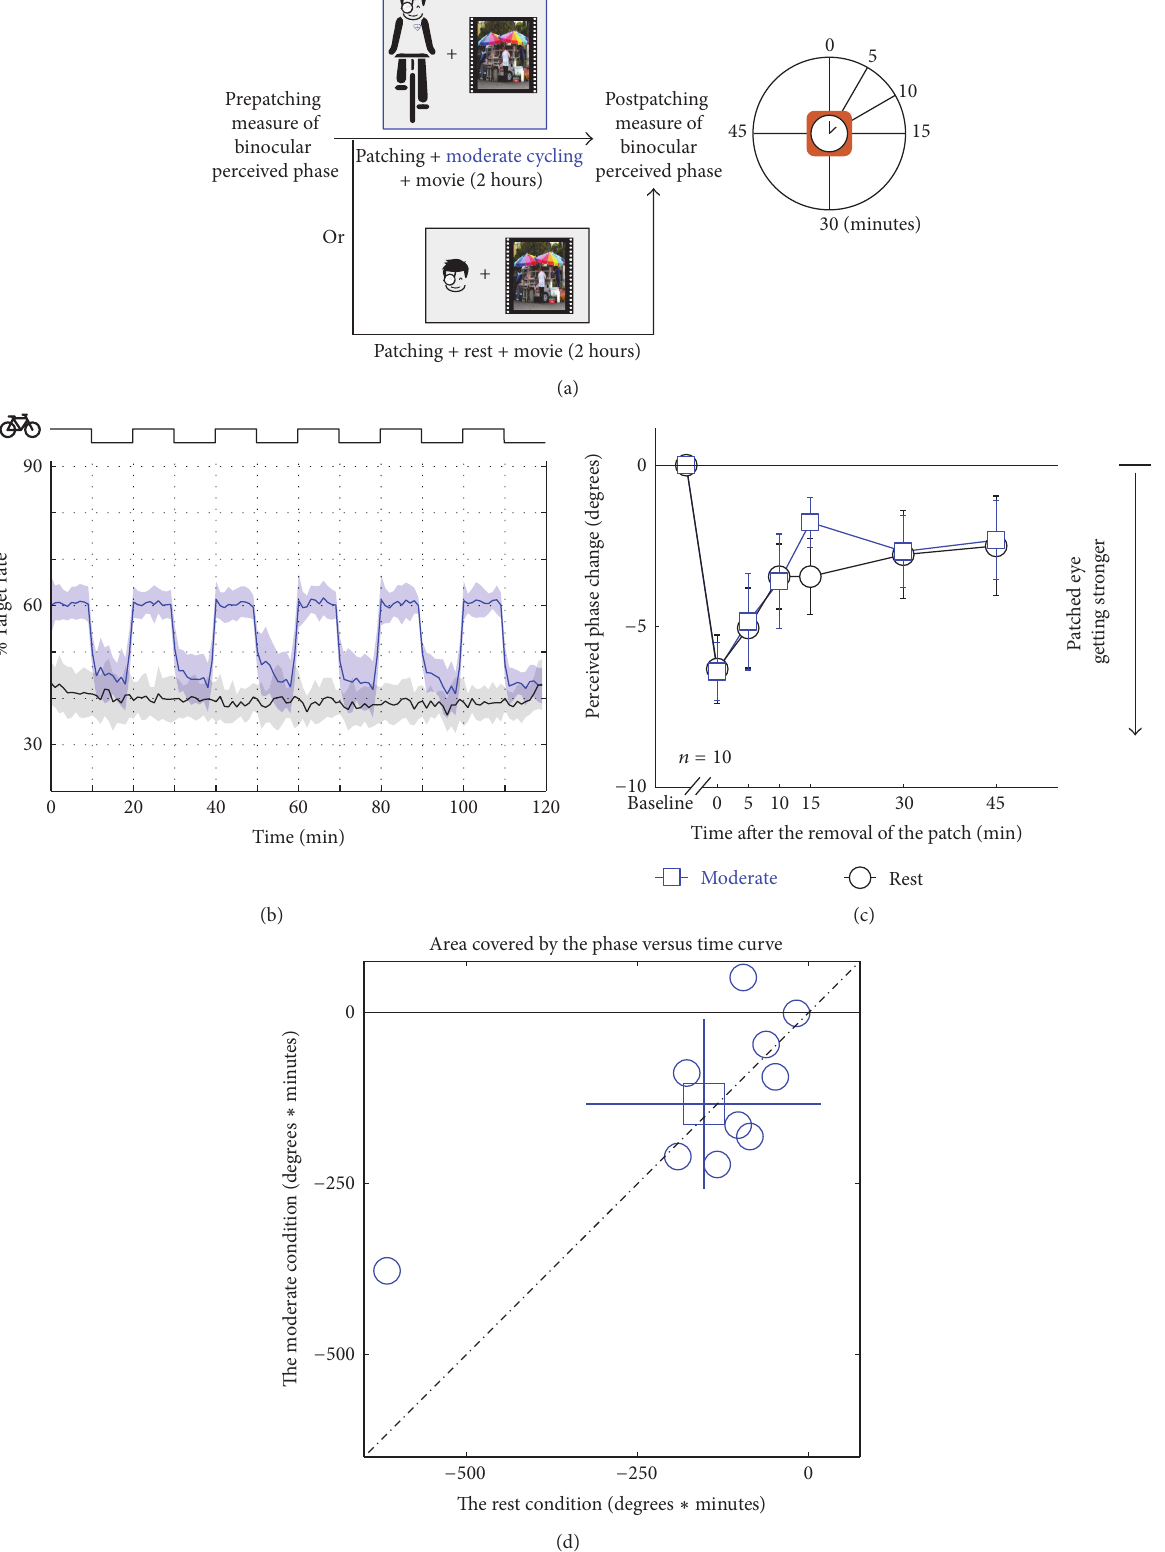
Figure 2: Illustration of the protocol for assessing the effect of moderate exercise on ocular dominance plasticity as a result of short-term monocular deprivation. Subjects ( 𝑛 = 10 ) are monocularly patched while cycling (10min cycling, 10min rest) and watching a movie for 2 hours (a). The exercise was intended to raise the heat rate by around 60% of its estimated maximum age-related heart rate (b). The change in ocular dominance as a result of the monocular deprivation is compared for the baseline (resting condition: black lines and open circles) and the exercise condition (blue lines and open squares) (c). The computed areal change (degrees × minutes) is compared for each subject at rest and after exercise; the open square symbol is the group mean ± SD